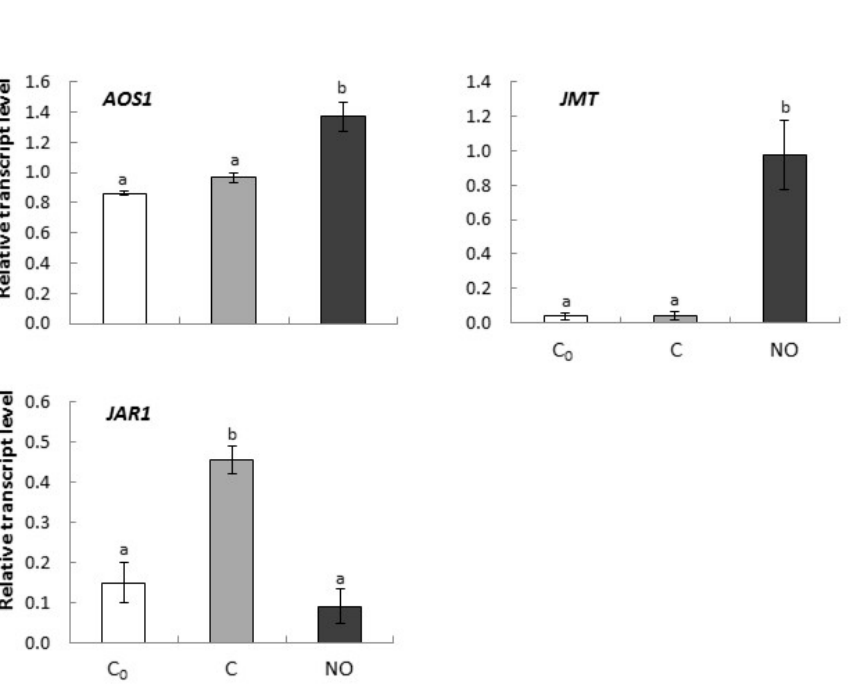
Figure 5. The relative expression level of genes encoding enzymes of JA biosynthesis ( AOS1 ), and JA derivatives formation ( JMT , JAR1 ) in axes of apple embryos isolated after 24 h of seeds imbibition in water (C 0 ), in axes of embryos imbibed in water for 3 h after seed coat removal (C), in axes of embryos fumigated with NO for 3 h (NO). The expression of genes was normalized to UBI as a reference gene. Two technical replicates were performed for each four biological replicates. Error bars represent ± SD; a, b homogenous groups.